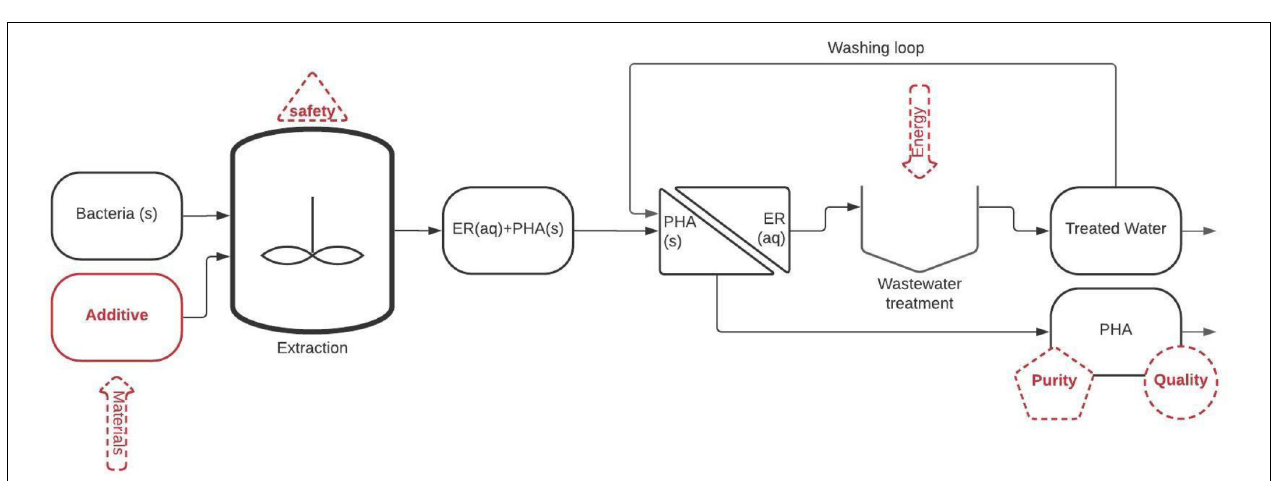
FIGURE 2 | General scheme representing the cellular lysis approach for recovering PHA form PHA rich bacteria. ER (aq), extraction residue dissolved in water; PHA, polyhydroxyalkanoate; PHA (s), polyhydroxyalkanoate in suspended solid